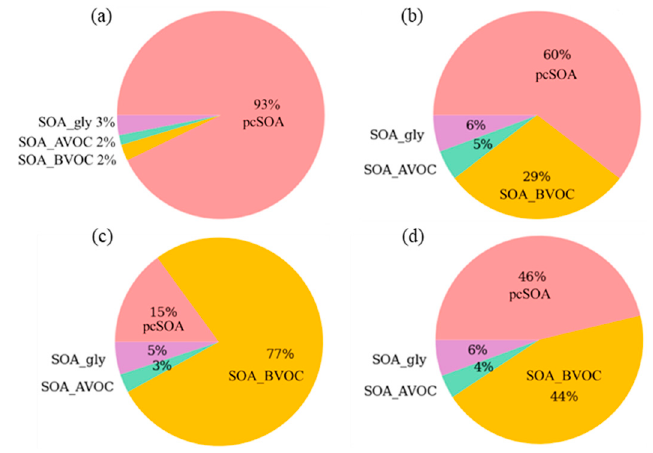
Figure 7. Modeled chemical compositions of secondary organic aerosols (SOAs) in winter ( a ), spring ( b ), summer ( c ), fall ( d ) in 2016 in Seoul. pcSOA: potential SOA from combustion, SOA_BVOC: SOA from biogenic volatile organic compounds (VOCs), SOA_AVOC: SOA from anthropogenic VOCs, SOA_gly: SOA from glyoxal and methylglyoxal.